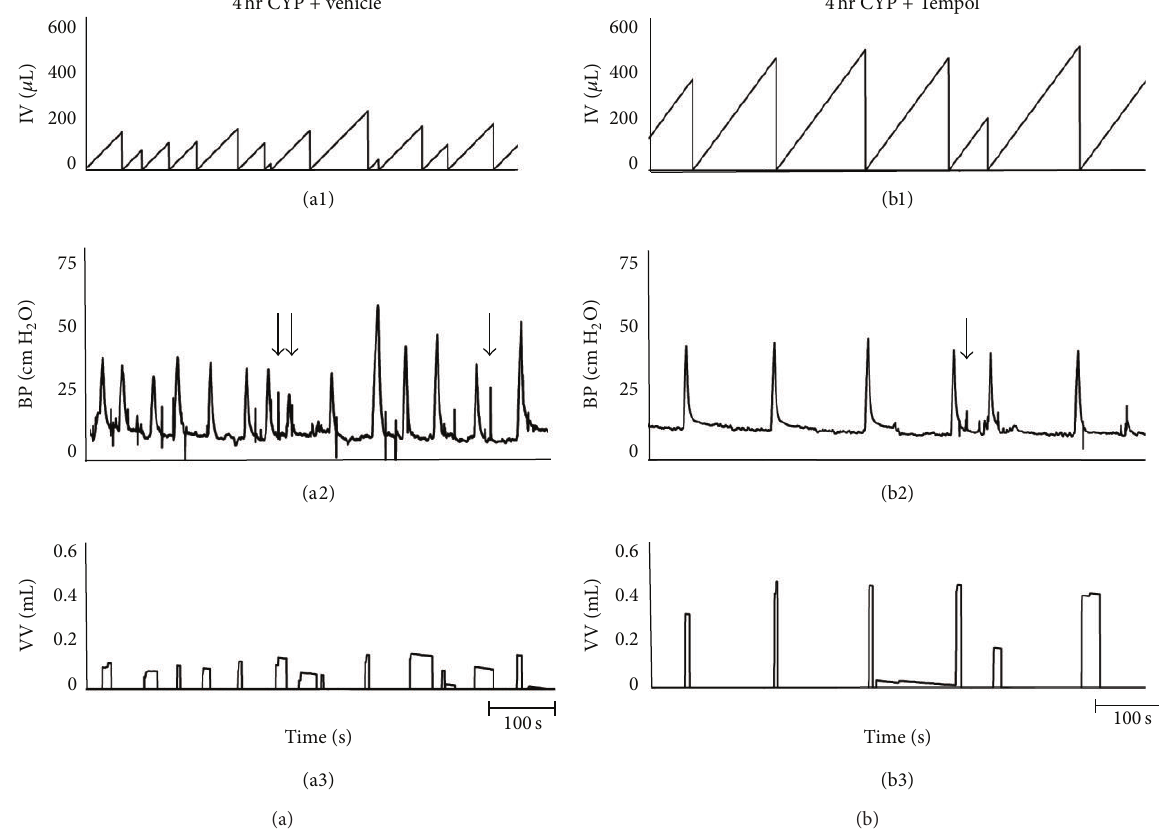
Figure 7: Representative cystometrogram recordings using continuous intravesical infusion of saline in conscious rats with an open outlet from a CYP-treated (4 hr) rat with vehicle ((a1)–(a3)) and a CYP-treated (4hr) rat with Tempol (1mM; (b1)–(b3)). ((a), (b)) Bladder function in a CYP-treated (4hr) rat without Tempol (vehicle only; (a1)–(a3)) and in a CYP-treated (4hr) rat with Tempol (1mM in the drinking water; (b1)–(b3)) during continuous intravesical infusion of saline. Bladder function recordings in (a) and (b) are from different rats. Infused volume (IF, 𝜇 L; (a1), (b1)), bladder pressure (BP, cm H 2 O; (a2), (b2)), and void volume (VV, mL; (a3), (b3)) with vehicle ((a1)–(a3)) and with Tempol treatment ((b1)–(b3)) are shown. Arrows ((a2), (b2)) indicate examples of nonvoiding contractions that were significantly ( 𝑃 ≤ 0.01 ) reduced in number and amplitude in CYP-treated (4hr) rats with